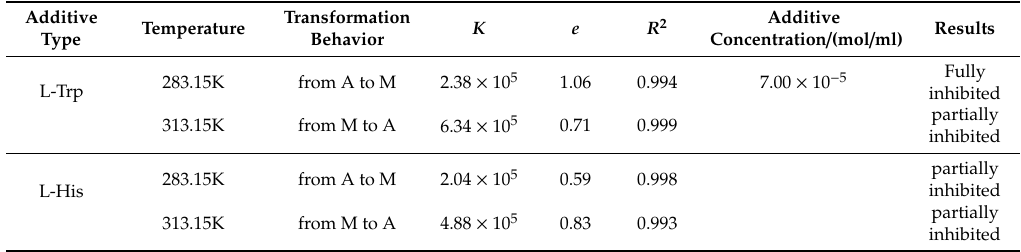
28.33 Table 5. The parameters of the Langmuir model. Additive Type